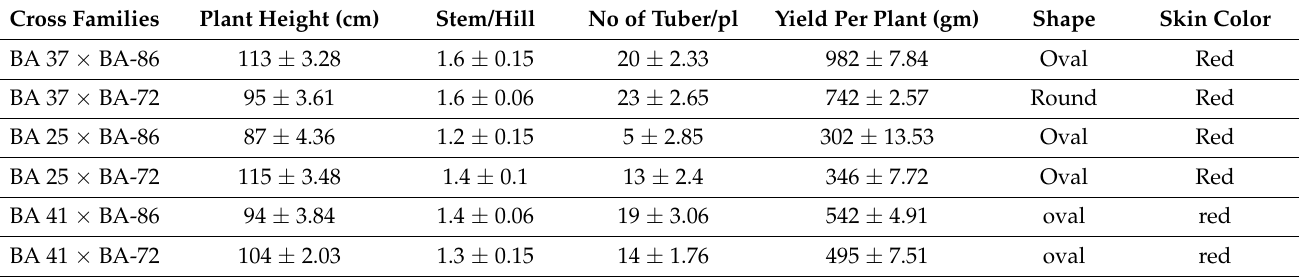
Table 3. Average agronomic performance and morphological characteristics of Cross/families grown in BSPC during 2019–2020